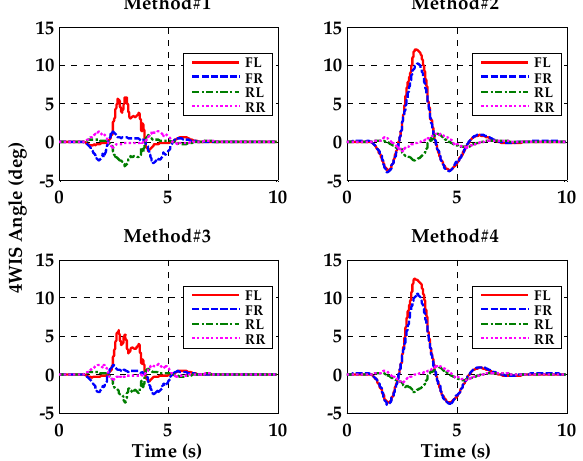
Figure 7. Steering angles of 4WIS for each method.